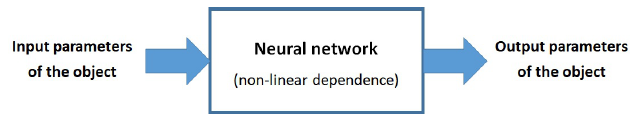
Figure 15. Primary structure of the object model.